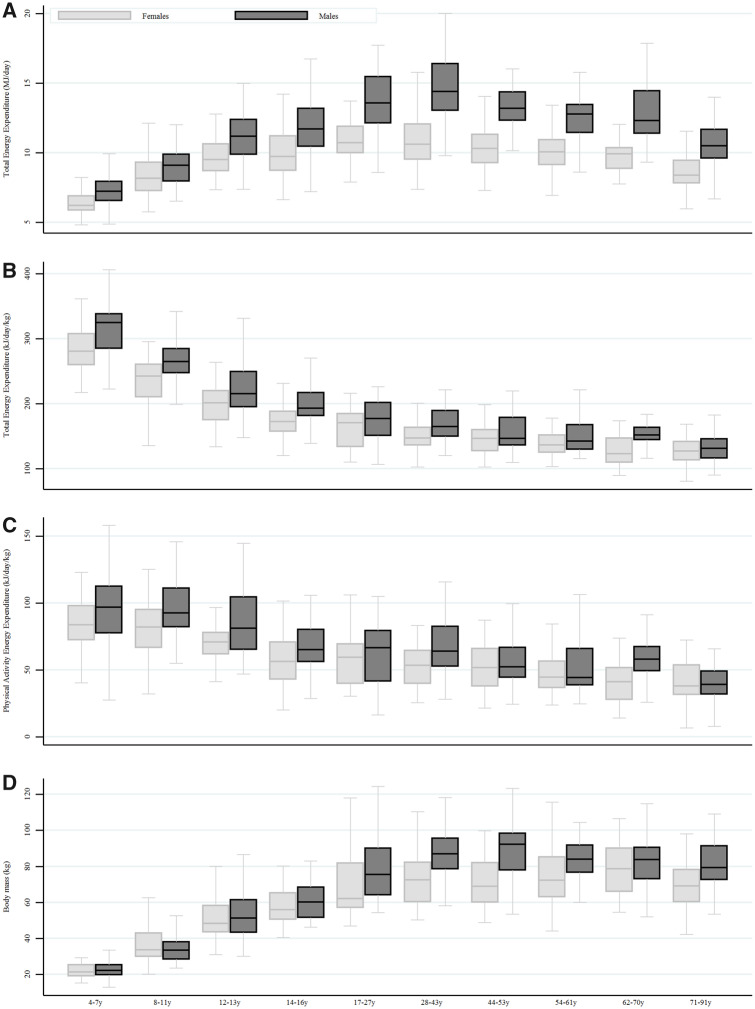
Total (panels A and B) and physical activity-related (panel C) energy expenditure by age (approximate deciles) and sex groups (females = light grey; males = dark grey). Bottom panel (D) shows stratified body mass.